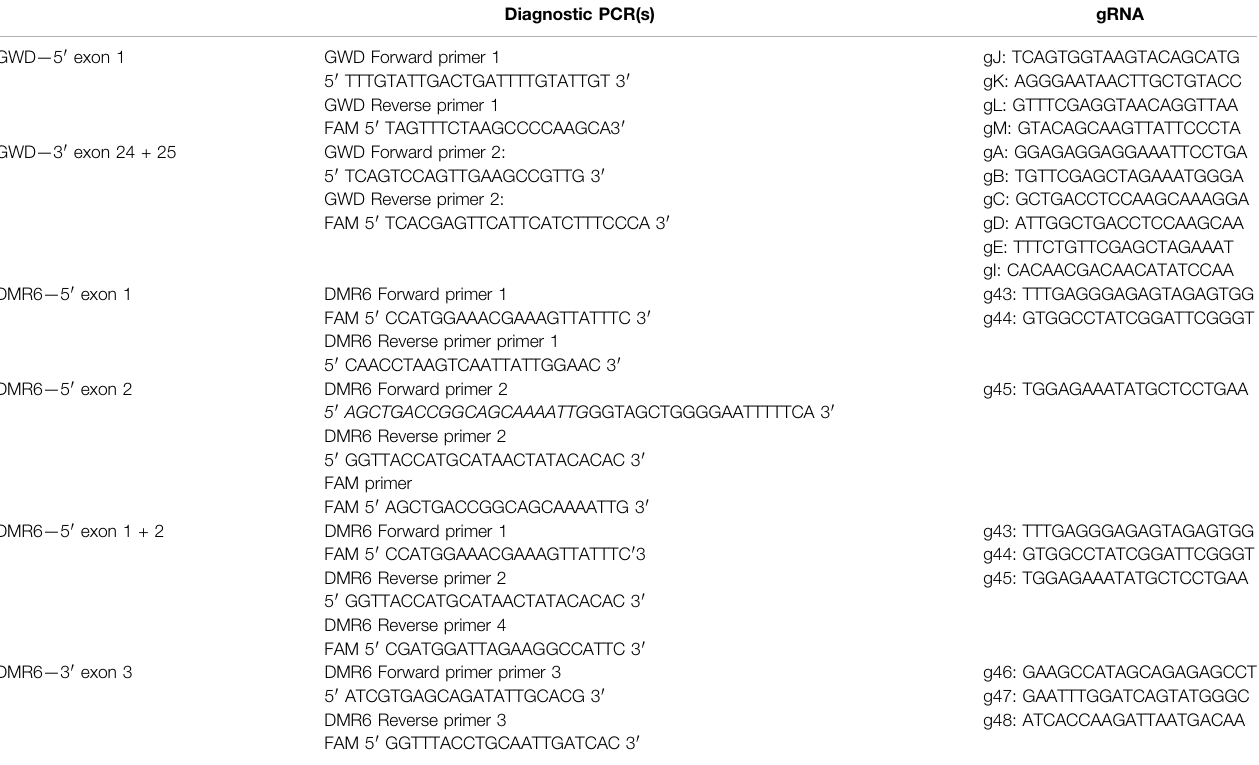
TABLE 1 | gRNAs and diagnostic IDAA primers for each of the four target regions. Scores and fi rst selection of gRNAs were obtained by feeding ca 1 kb regions to the in silico prediction servers CHOPCHOP (http://chopchop.cbu.uib.no/), CRISPRater (https://crispr.cos.uniheidelberg.de/) and SSC (http://crispr.dfci.harvard.edu/SSC/). Diagnostic